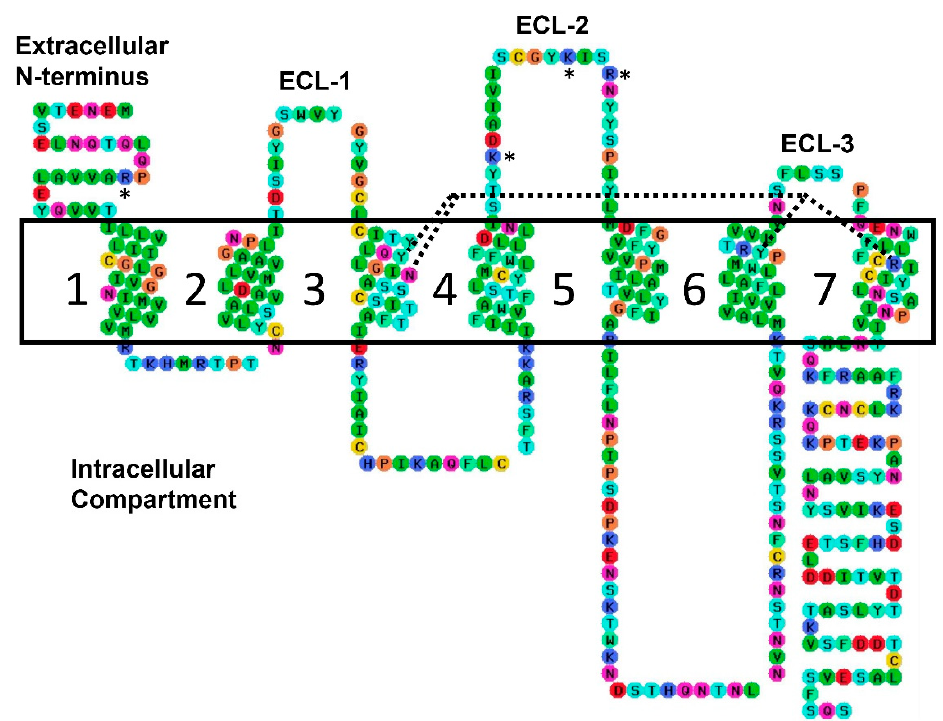
Figure 3. A two-dimensional outline of the hTRH-R peptide sequence pointing out the four direct binding contacts with Tyr-106, Asn-110, Tyr-282 and Arg-306 marked by dashed lines. The ECD’s positively charged residues are identified with asterisks. The TM helices are numbered (1–7), and the three ECLs are labeled. Color coding: red—Charged (negative), blue—Charged (positive), green—Hydrophobic, aqua—Aromatic, cyan—Hydrogen bond donor/acceptor, orange—Special cases, and yellow—Cys. The ECD’s positively charged residues are identified with asterisks.